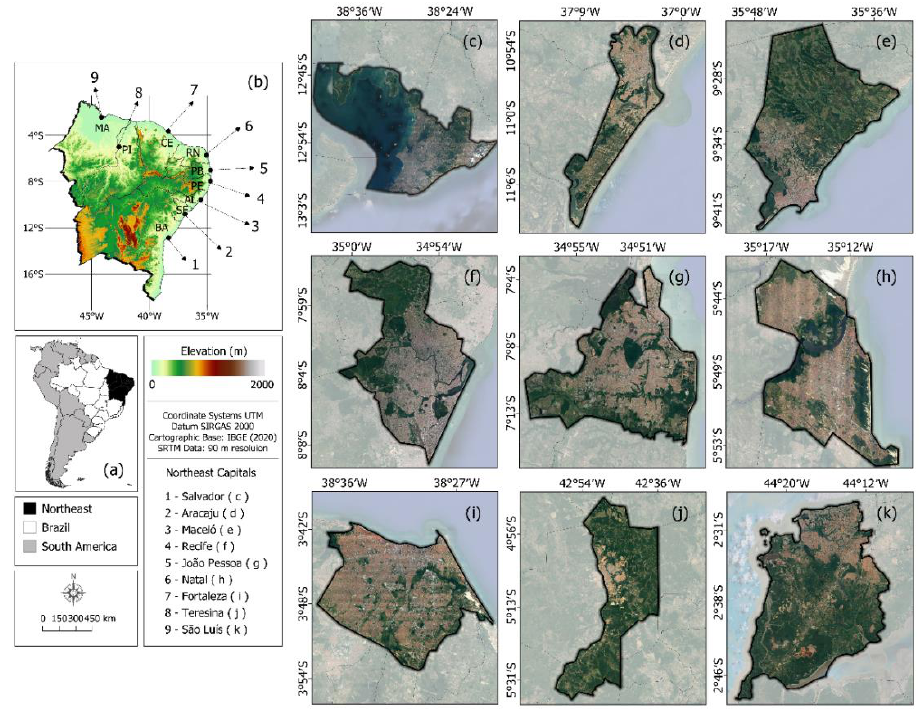
Figure 1. Location of the study area, with emphasis on the nine capitals and the elevation (m) of the NEB. Legend: ( a ) Brazil, ( b ) elevation in Northeast region, ( c ) Salvador, ( d ) Aracaju, ( e ) Macei ó , ( f ) Recife, ( g ) Jo ã o Pessoa, ( h ) Natal, ( i ) Fortaleza, ( j ) Teresina and ( k ) S ã o Lu í